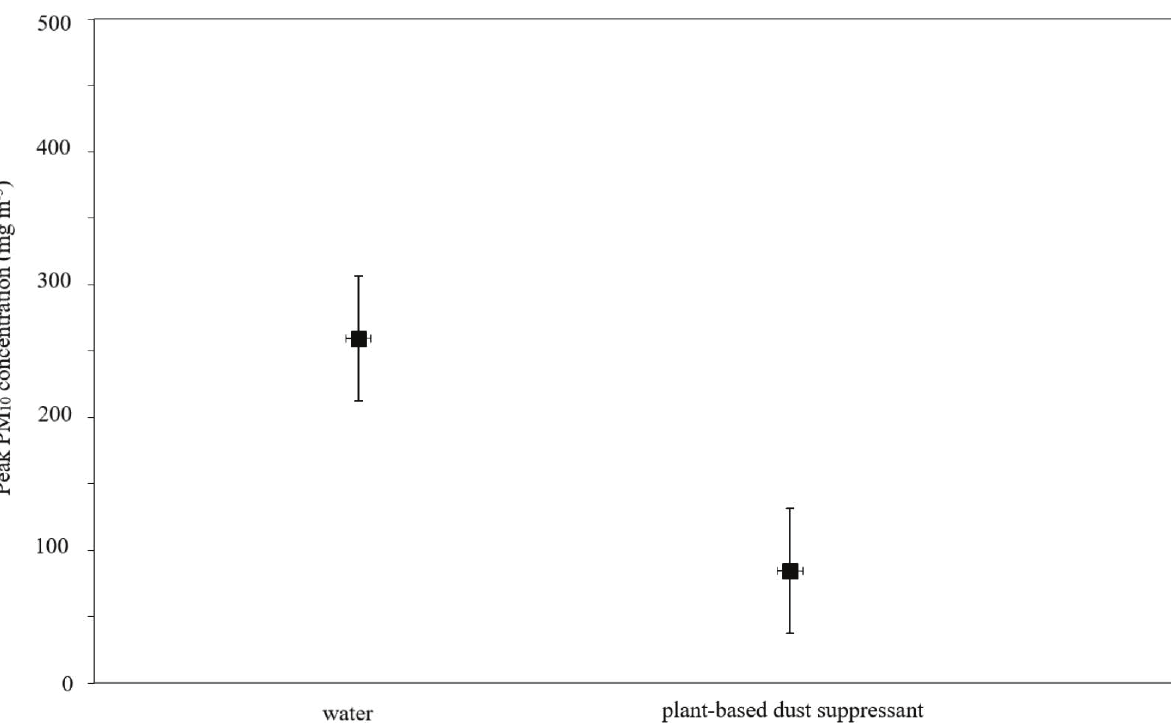
concentration (mg m –3 ) 10